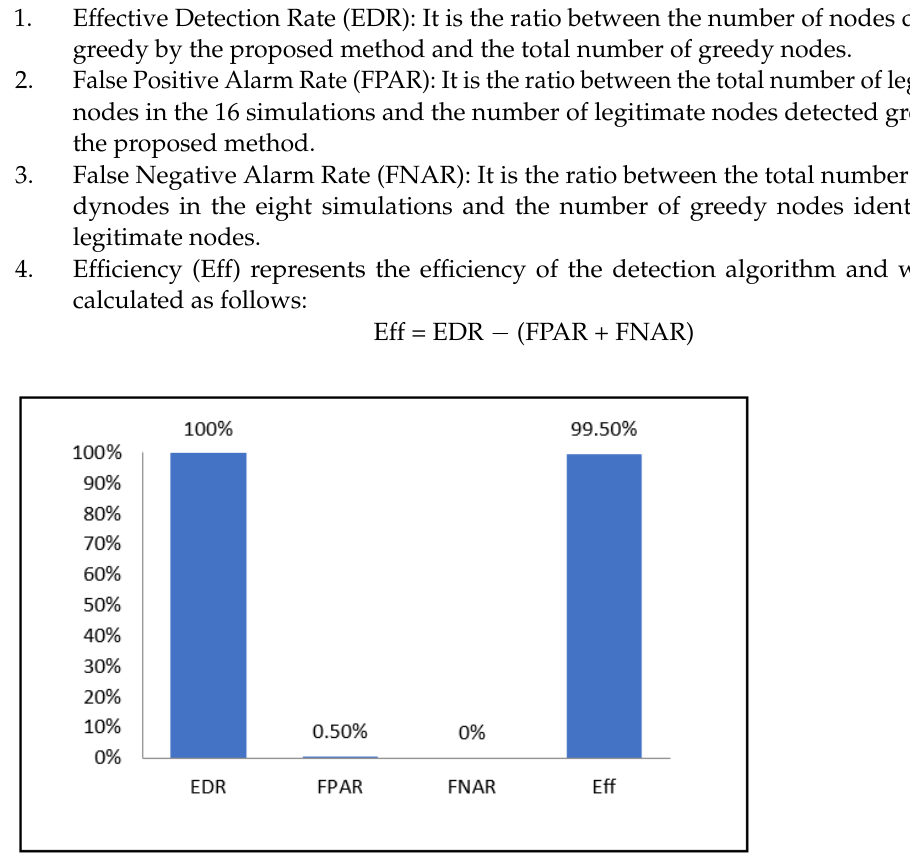
Figure 7. Greedy node identification results. The simulation results demonstrated an efficiency of 99.5%. The effective detection rate is 100% since the proposed method has allowed the identification of all greedy nodes in the eight compromised networks. Therefore, there was no false negative alarm. On the other hand, there was only one false positive alarm in network N 3 . Thus, 1 in 200 legitimate nodes has been detected as being